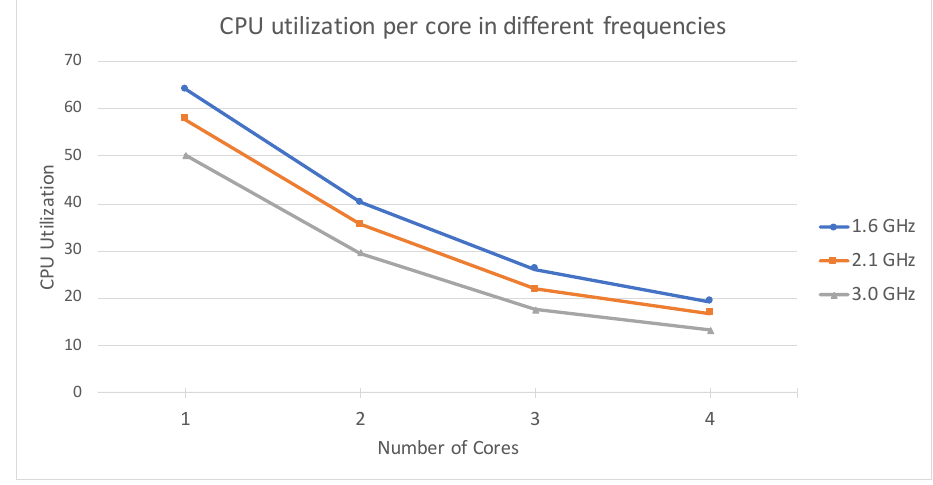
Figure 5. Average utilization per core on different frequencies for a high demand task on a SDN controller.